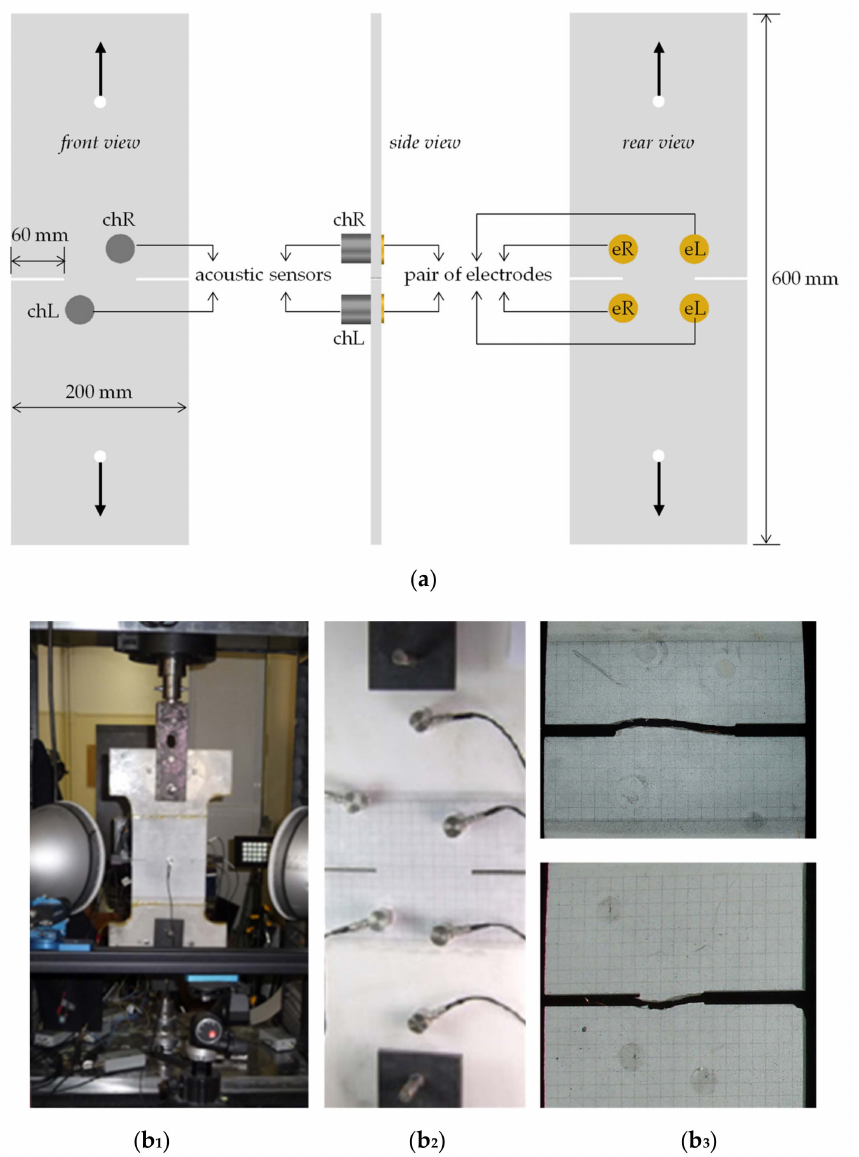
Figure 3. ( a ) Sketch of the specimens together with the most critical dimensions; ( b 1 , b 2 , b 3 ) detailed view of a typical specimen while being prepared for testing ( b 1 ), the arrangement of an increased number of acoustic sensors in the preliminary stages of the experimental protocol (in order to detect parasitic signals and quantify the potential role of marble anisotropy) ( b 2 ) and characteristic fractured specimens indicating the wavy form of the crack propagation ( b 3